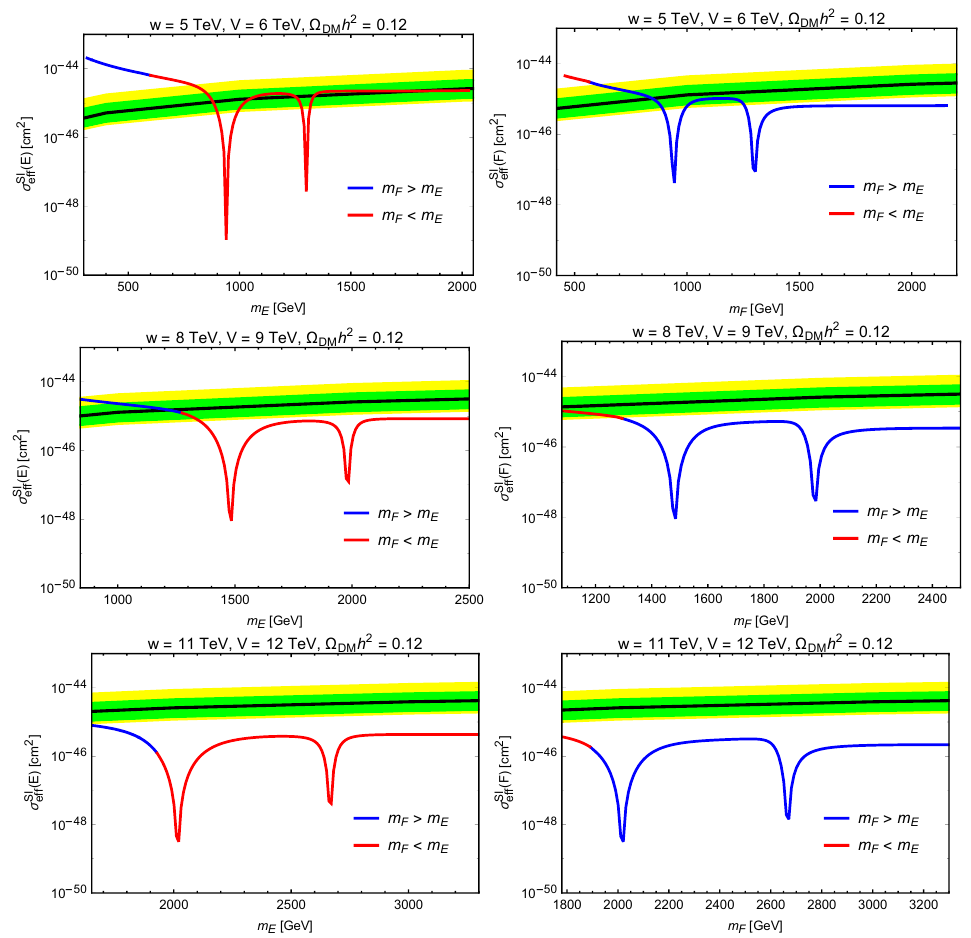
Figure 7 . The spin-independent dark matter-nucleon scattering cross-section limits as a function of dark matter masses according to ( w; V ) = (5 ; 6), (8,9), and (11,12) TeV, assuming the correct abundance (cid:10) DM h 2 = 0 :